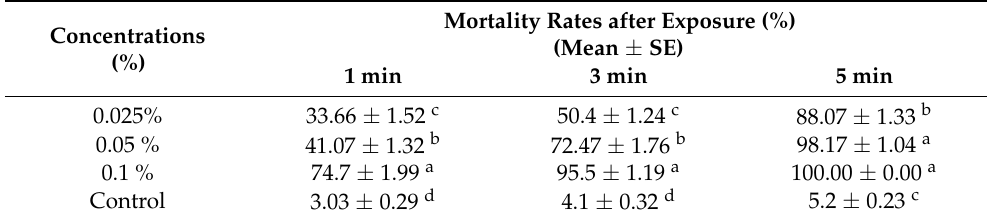
Table 2. Scolicidal effect of Lavandula stoechas essential oil on the viability of E. granulosus protoscolices. Concentrations